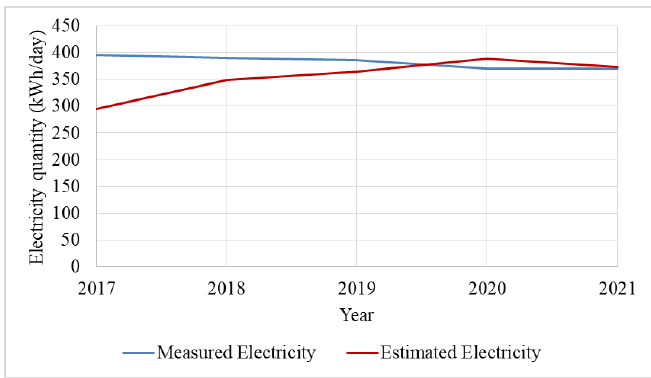
Figure 2. The estimated amount of electricity for a 98.8 kW PV power plant. Table 8. The estimated amount of electricity for a 3 MW PV power plant.